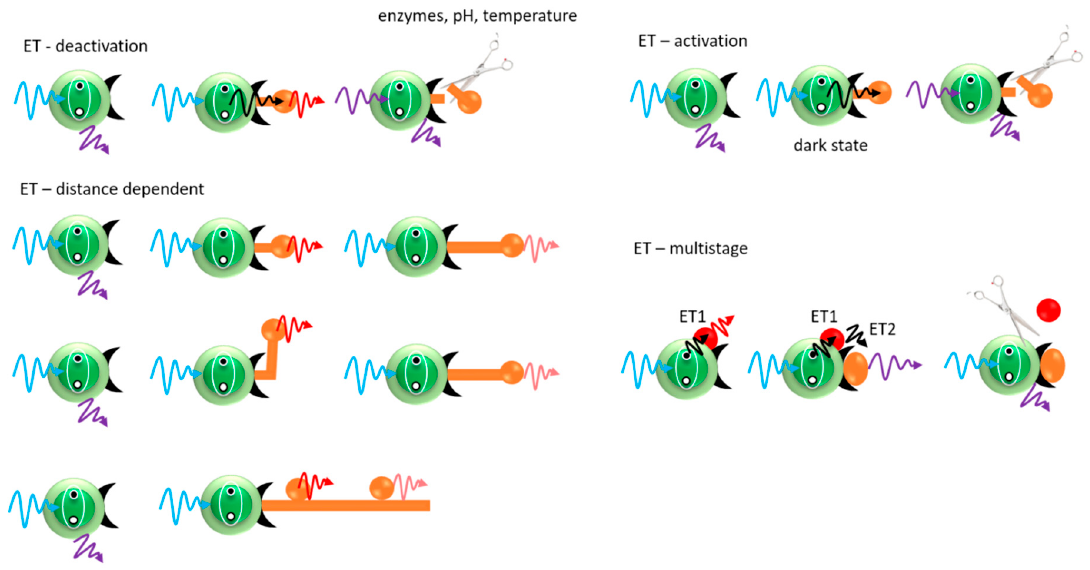
Figure 7. Different detection possibilities with use of nonradiative energy-transfer phenomena.